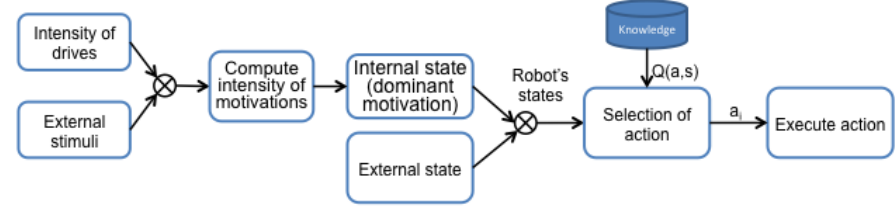
Figure 1. Steps followed by our